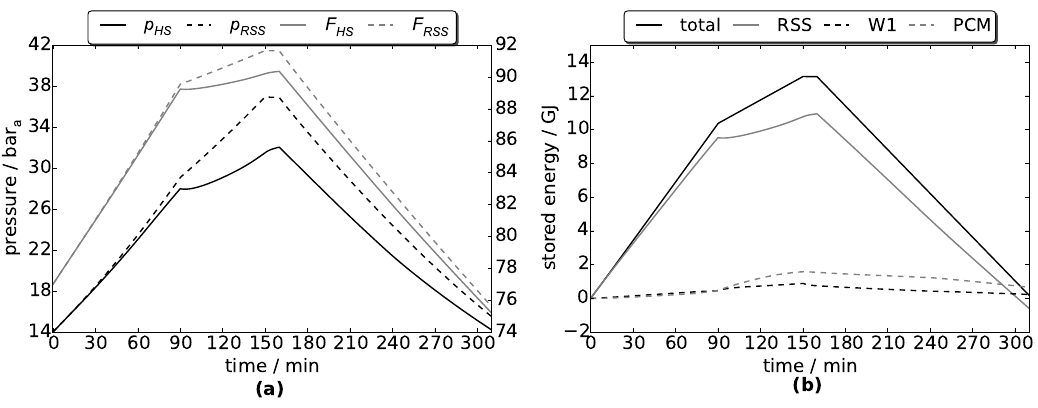
Figure 13. Hybrid storage example results. ( a ) Pressure p and liquid filling level F inside the RSS sub-model for the hybrid storage (HS) and the RSS. ( b ) Total stored energy compared to the stored energy in different hybrid storage